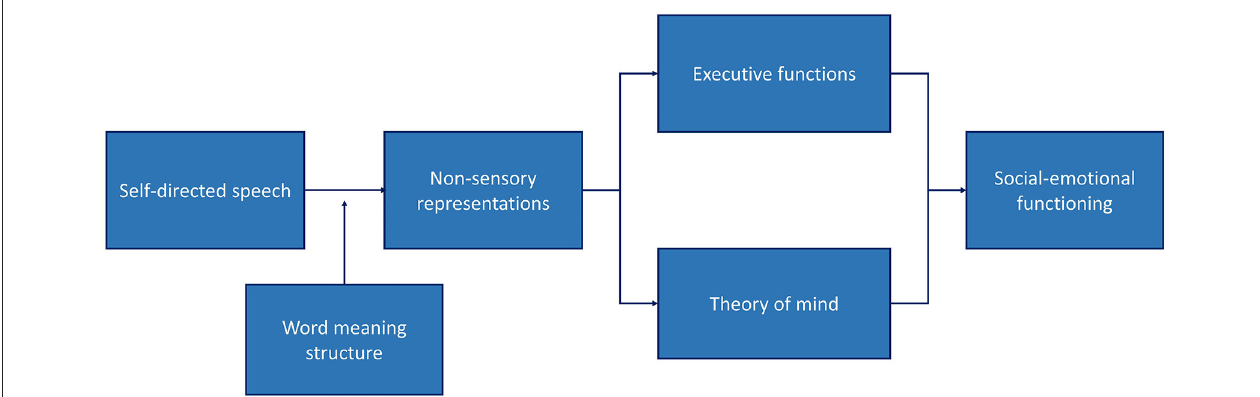
FIGURE 1 | A Vygotskian account of the social–emotional problems of individuals with hearing and language problems. Social emotional functioning can be explained in terms of executive functioning and theory of mind, which in turn are affected by non-sensory representations created in self-directed speech. Non-sensory representations are images or descriptions corresponding to external events that do not coincide with direct observation. The ability to construct non-sensory representations is constrained by the level of word meaning